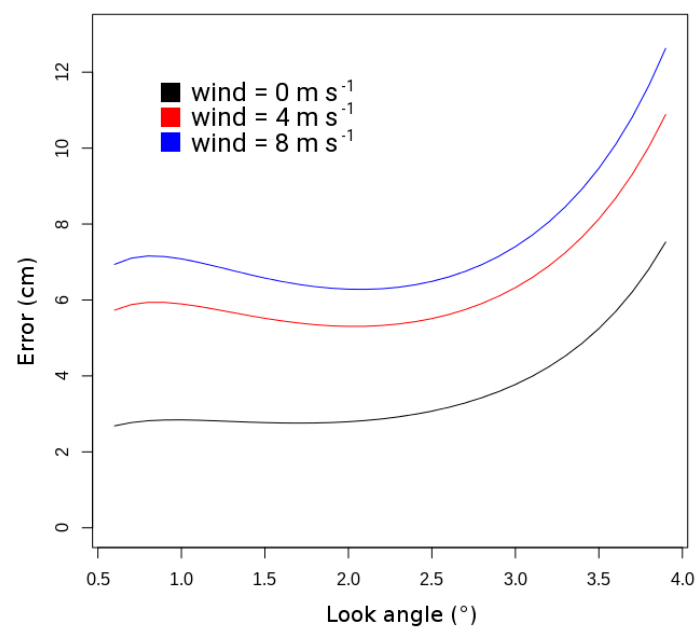
Figure 10. SWOT error measurement as a function of the look angle for a wind speed of 0 m s − 1 , 4 m s − 1 , or 8 m s − 1.